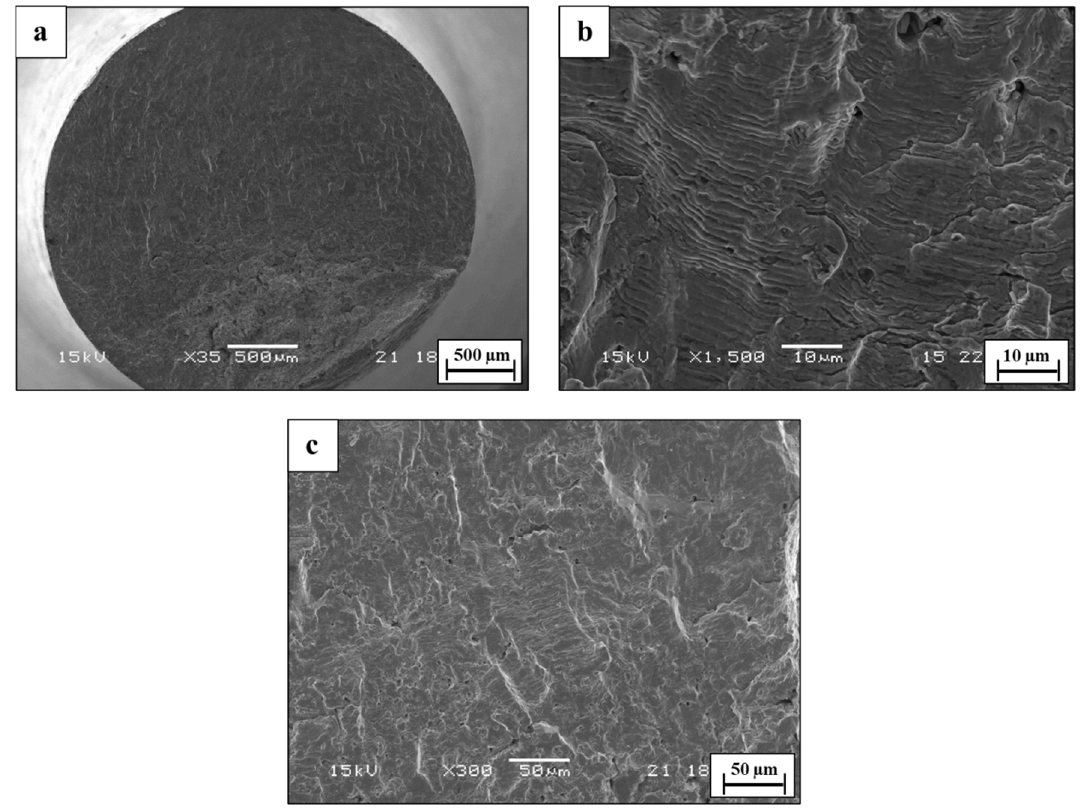
Figure 13. Fractography analysis of counterpart AISI 316L alloy in air (S = 340 MPa, N = 8,398,345). ( a ) General view ( b , c ) close-up view.